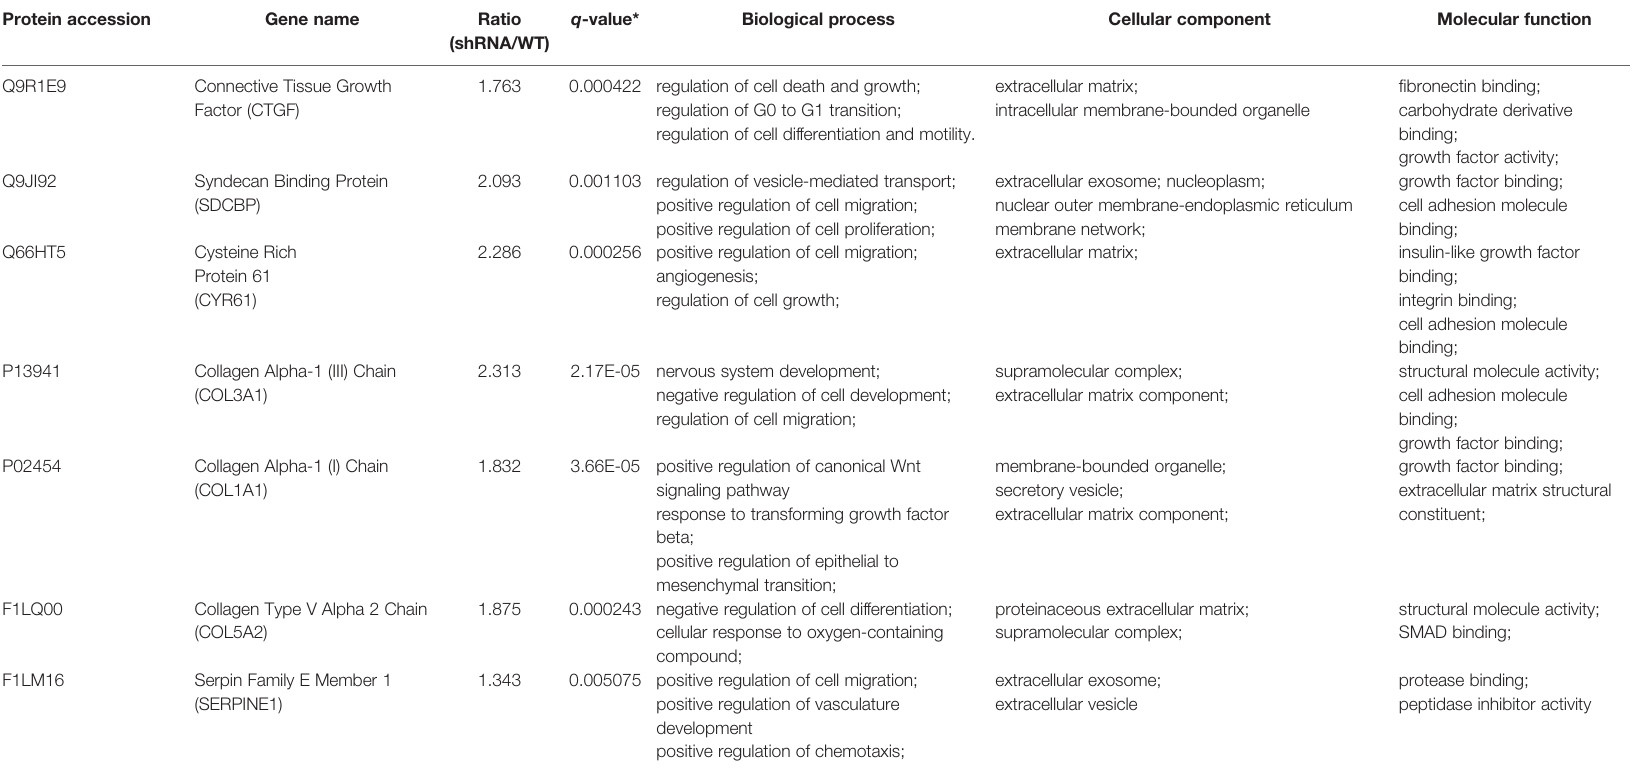
*q-value indicate the p-value after FDR